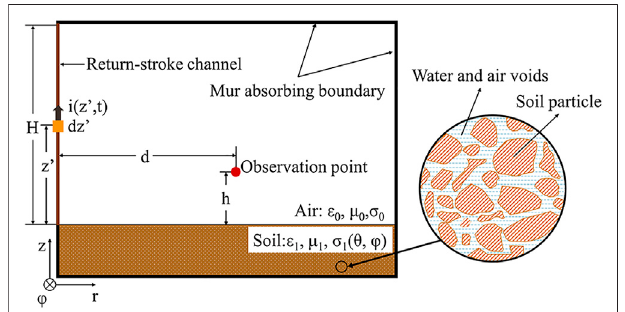
FIGURE1 | Geometry: 2-DFDTD simulationmodel ofLEMFs for thesoil considering both soil water content and